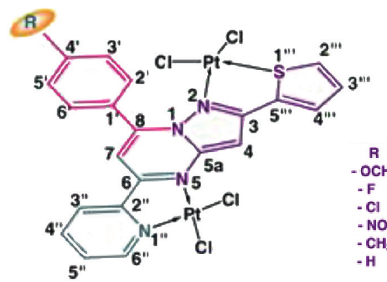
Figure 6 Coordination of tetradentate pyrazolo-pyrimidine in the binuclear platinum (II) complex [42]